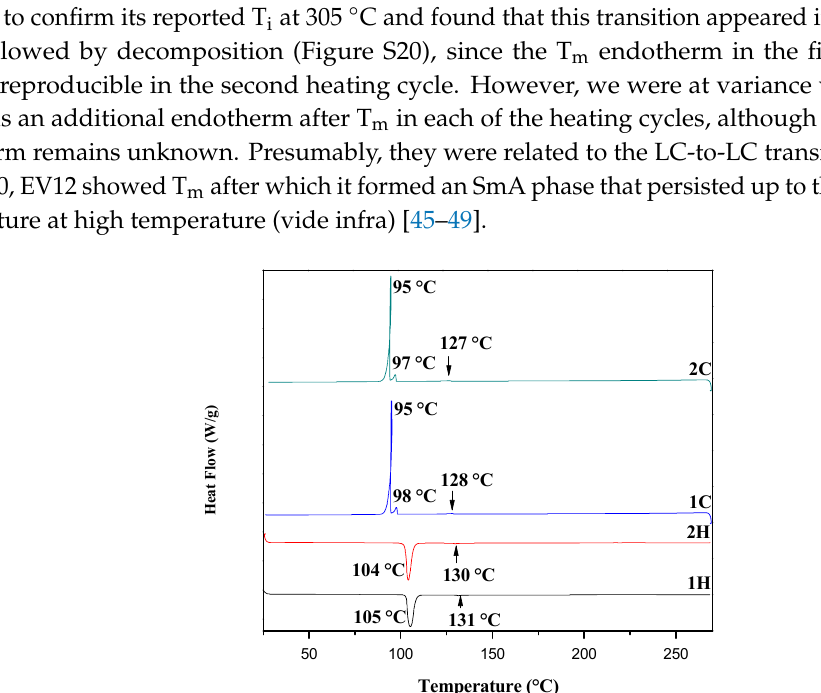
Figure 8. DSC thermograms of EV12 obtained at heating and cooling rates of 10 °C /min.